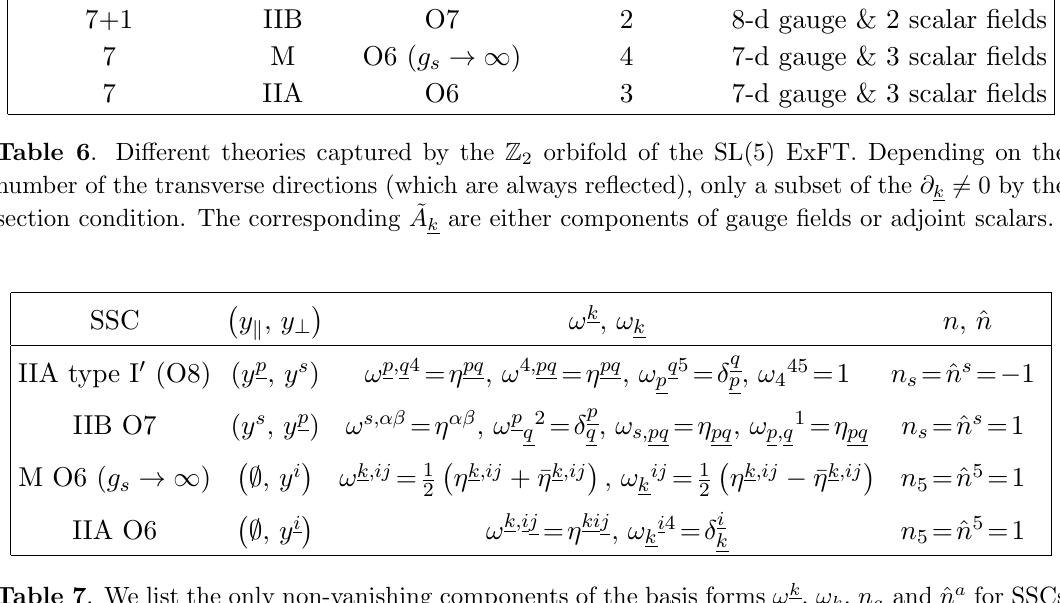
/ y ⊥ denote the physical coordinates k